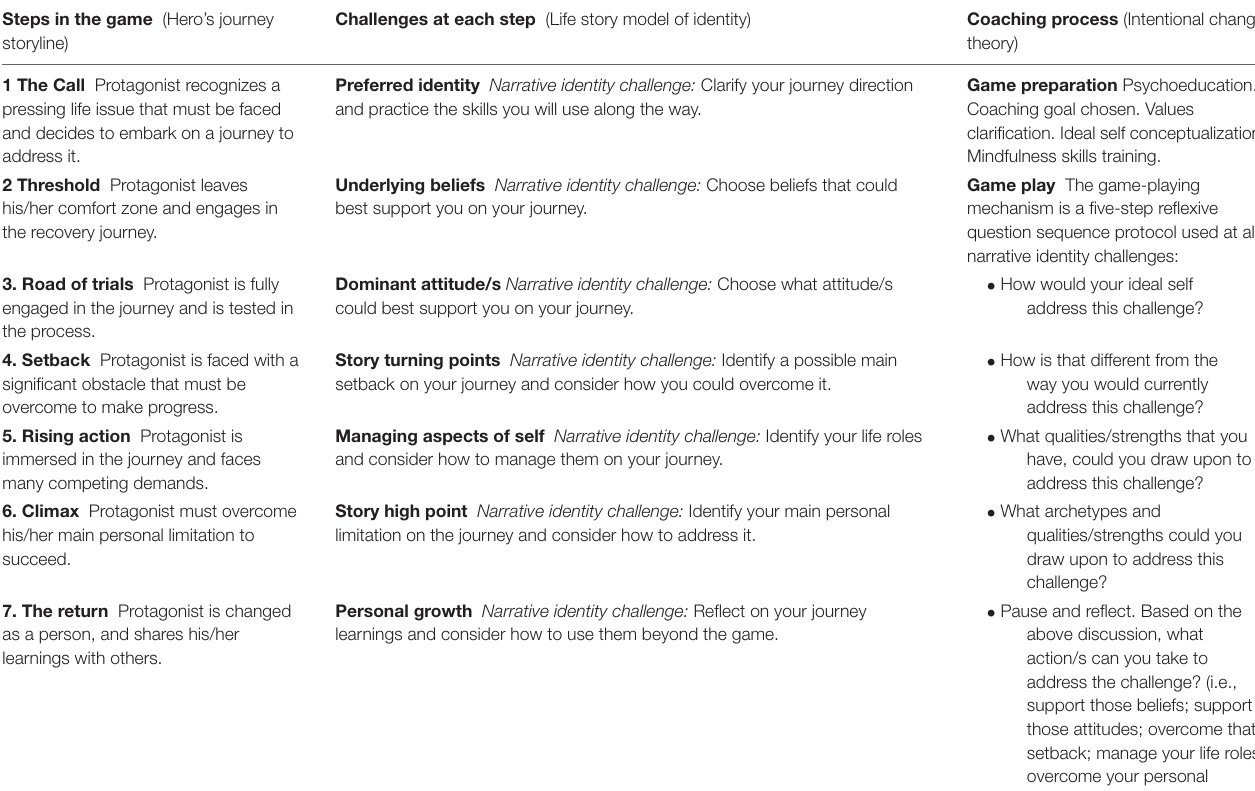
TABLE 2 | An overview of the coaching boardgame designed to facilitate narrative identity reconstruction. Steps in the game (Hero’s journey Challenges at each step (Life story model of storyline)